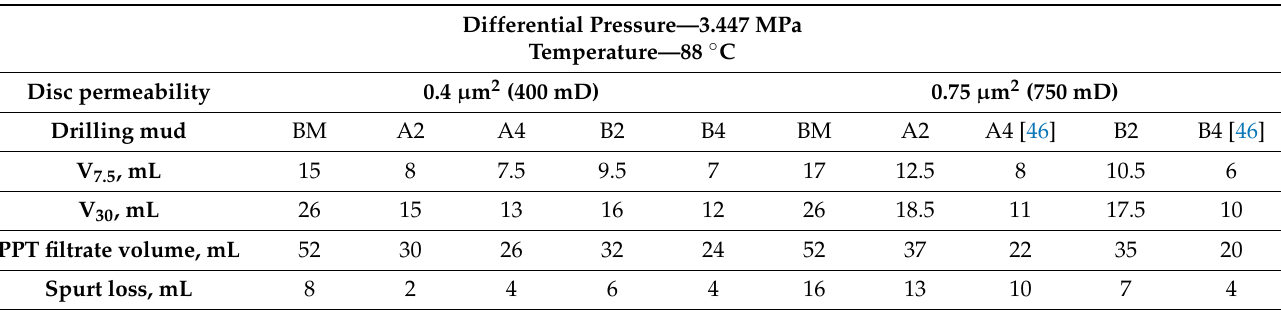
Figure 6. SEM images of mud cakes obtained after API filtration of BM (A4 and B4). Table 4. Influence of adding MPP on PPT filtration. Table 4 summarizes the data of the PPT filtration measurements for both mud samples containing 1% (A2 and B2) and 2% (A4 and B4) of MPP by volume of water.